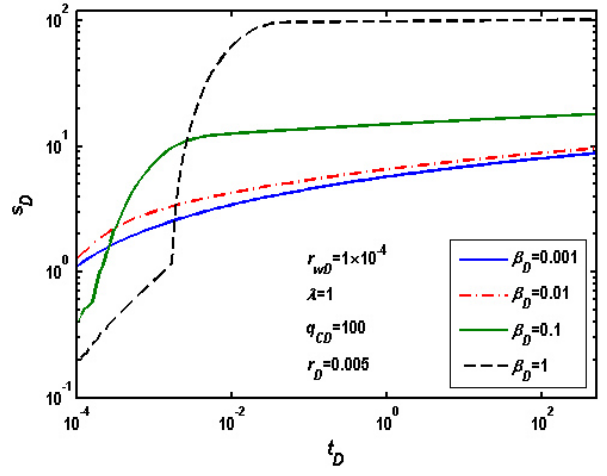
Figure 7. Time-drawdown at r D = 0 . 005 for different inertial force coefficients in a log–log